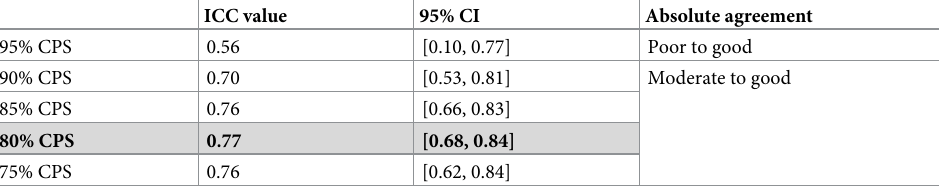
Table 3. Absolute agreement (ICC values and their 95% confidence intervals) between CPS values estimated with the SDev and the NLME methods for five different definitions of